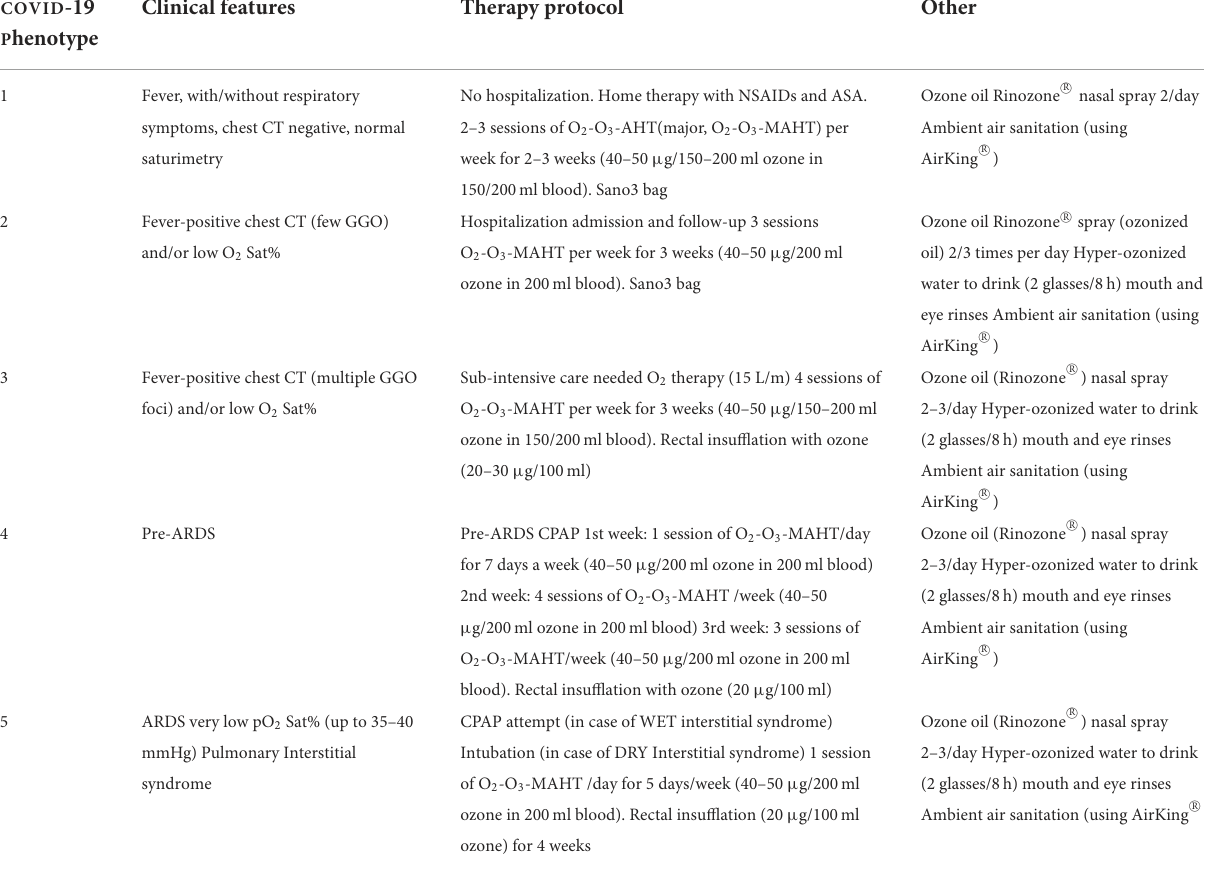
TABLE 1 SIOOT protocol for the treatment of SARS-CoV-2 infection. COVID